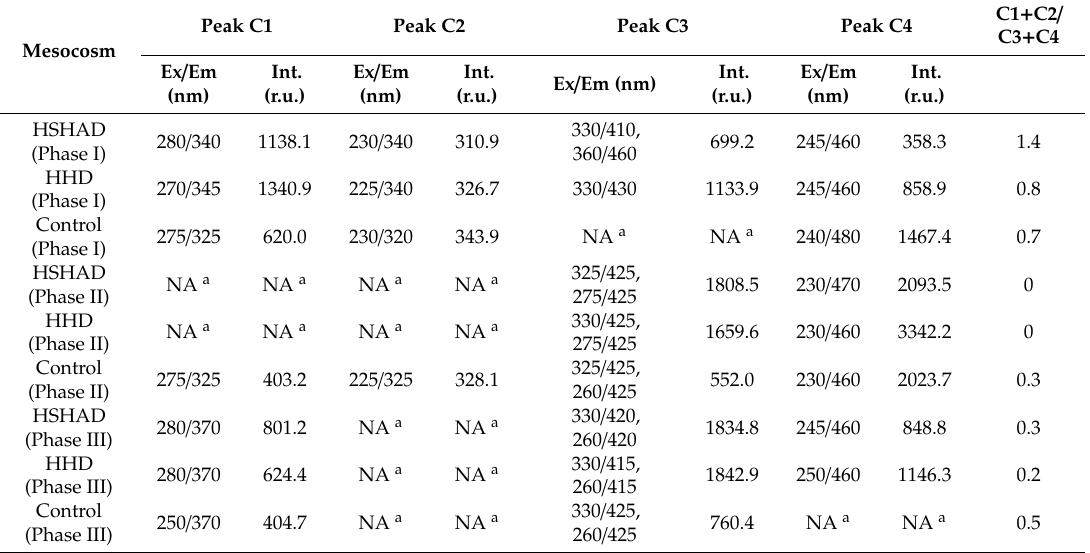
Table 3. Spectral characteristics of excitation (Ex) and emission (Em) maxima of four components in each phase (Intensity